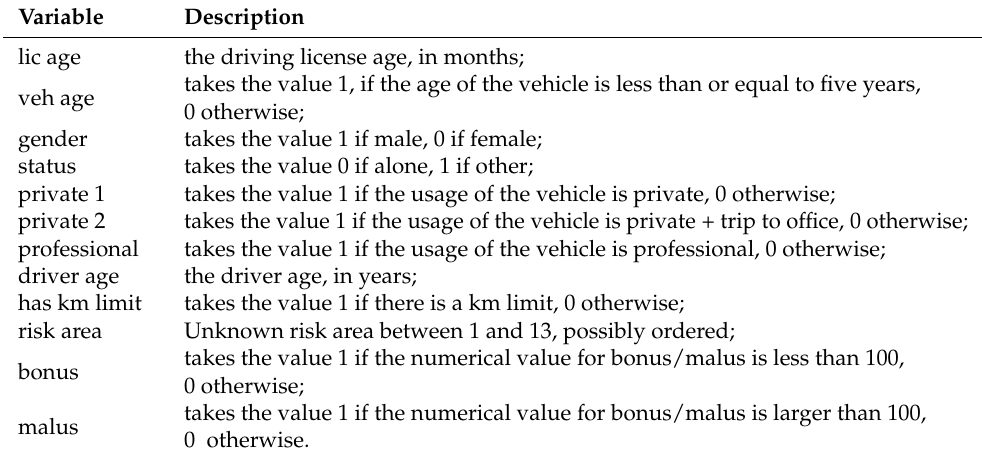
Table 2. Description of factors and explanatory variables